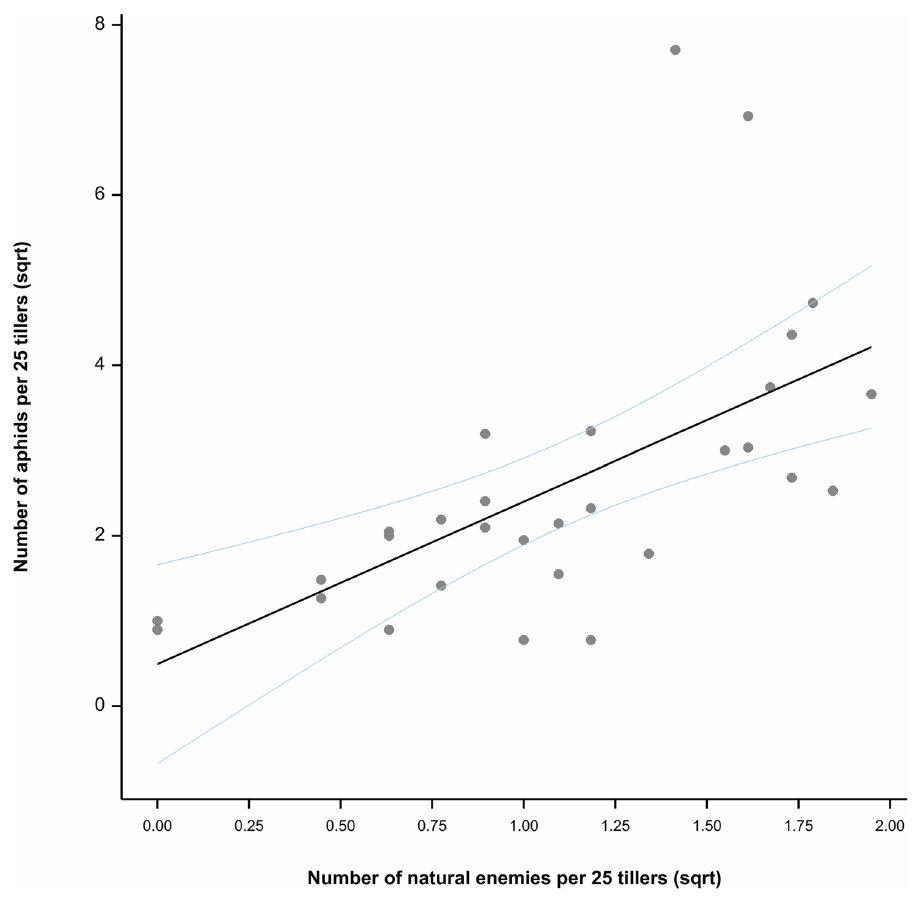
Figure 6. Correlation between the average number of aphids per 25 tillers and the average number of natural enemies per 25 tillers. Data was subject to square root transformation.